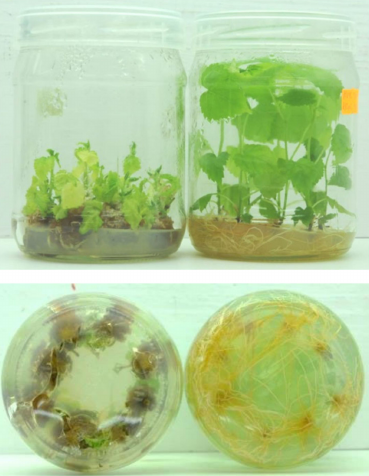
Figure 5. Performance of in vitro shoot cultures of mountain mulberry ‘Kenmochi’ propagated through axillary-branching (left jar) and single-node (right jar) method (on cytokinin-containing and cytokinin-free media, respectively). Note the di ff erences in elongation of shoots, immoderate growth of callus in “AxB” cultures, and profuse growth of roots in “SNC” cultures.